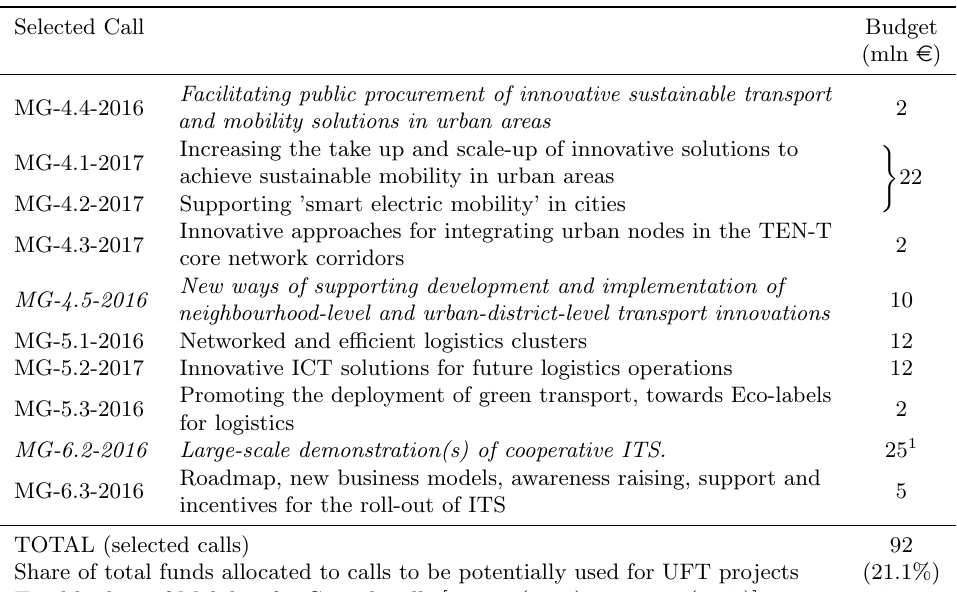
Table 4: H2020 Work Programme 2016-2017: a budget